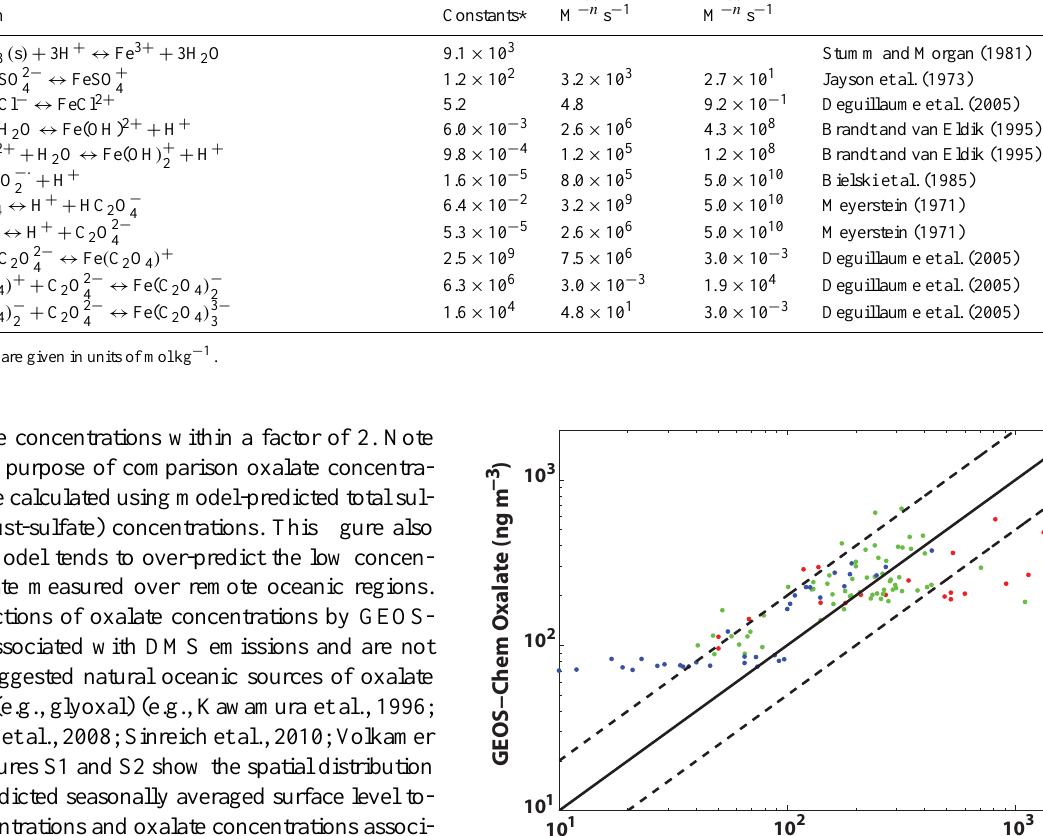
Table 4. Aqueous-phase reactions in GEOS-Chem/Fe d and their equilibrium constants. Equilibrium Equilibrium K 298 (forward) K 298 (back) Source Reaction Constants* M − n s − 1